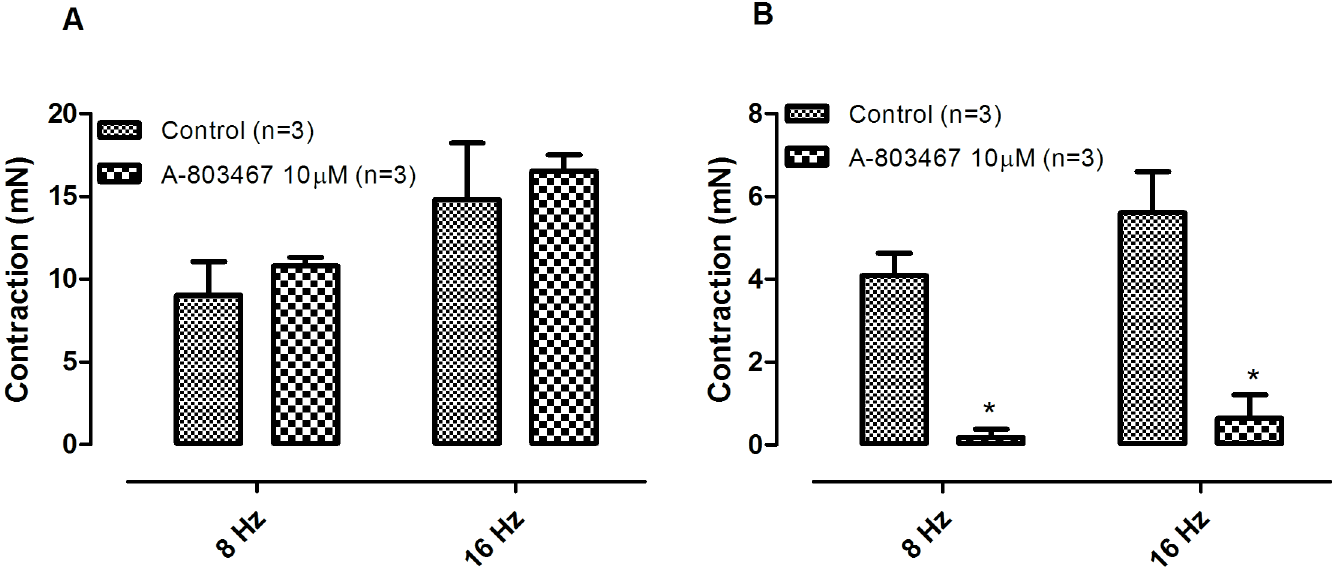
Fig 4. Effect of A-803467(10 μ M) on EFS-induced contractions of corpora cavernosa isolated from Crotalus (A) and rabbit (B) . Data are expressedas mean ± standarderror mean (S.E.M) pairedStudent’s t test, * P < 0.05 vs control.